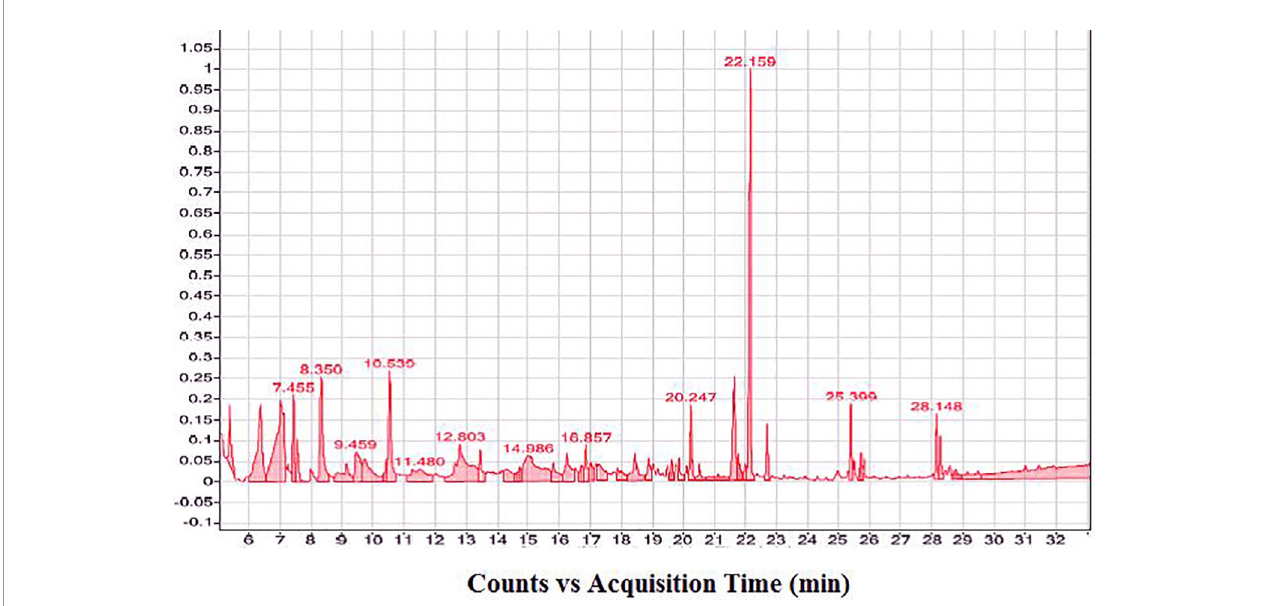
FIGURE 1 | GC-MS analysis of the identi fi ed compounds of Lagenaria siceraria seed extract.